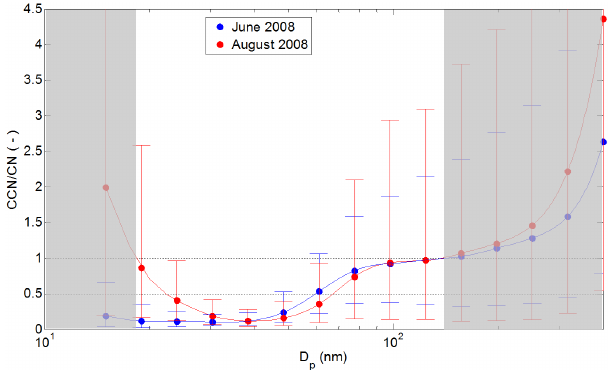
Figure 8. Activation ratio as a function of dry particle diameter ( D p ) for the measurement period in June 2008 and August 2008. Obtained from measurements at a SS of 0.4%. Error bars indicate SD. The grey area indicates the for further analysis omitted